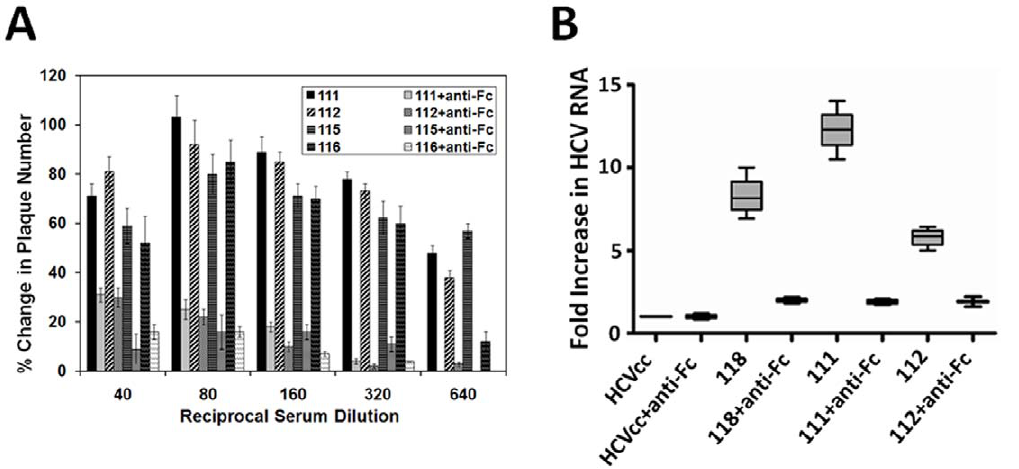
Figure 6. Enhancement of VSV/HCV pseudotype infection via serum addition is dependent upon Fc region of the IgG. A Fab fragment was used to block the attachment of the Fc region of virus adsorbed antibody to hepatocytes subsequent to the binding of the antibody to the pseudotype virus. Non-neutralizing vaccine sera added to pseudotype virus (panel A) or HCVcc (panel B) were treated with 2 mg anti-Fc Fab for 15 minutes prior to addition on Huh-7 cells for infectivity. Virus supernatants treated only with the Fc-Fab fragment were used as controls.